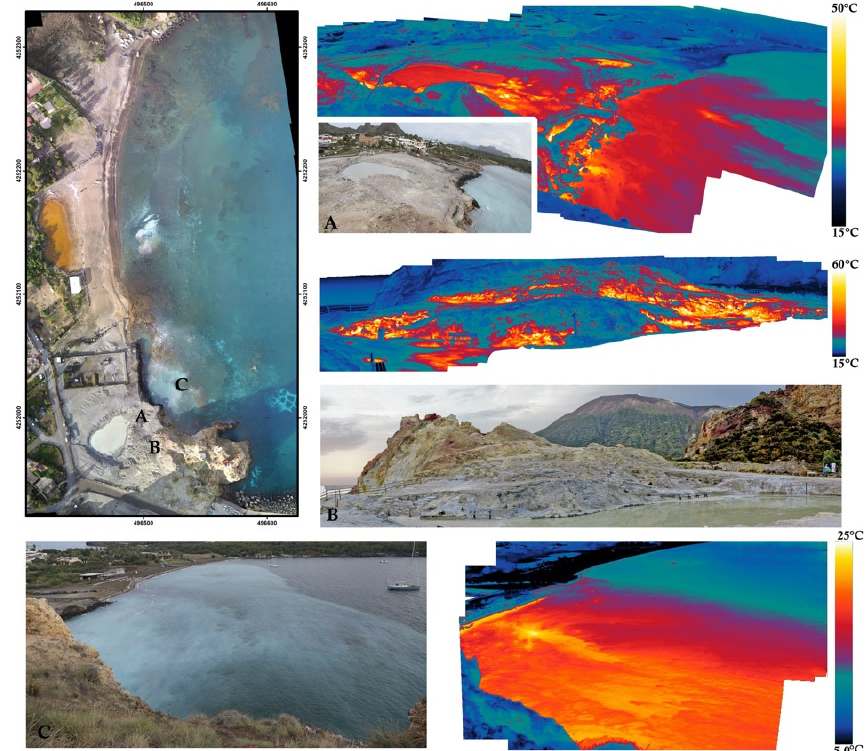
Figure 4. On the left, the Baia Levante beach orthophoto, the letters mark the thermal surveys: ( A , B ) and ( C ) photographs and forward-looking infrared radiometer (FLIR) thermal infrared (TIR) images documenting the anomalous thermal areas.